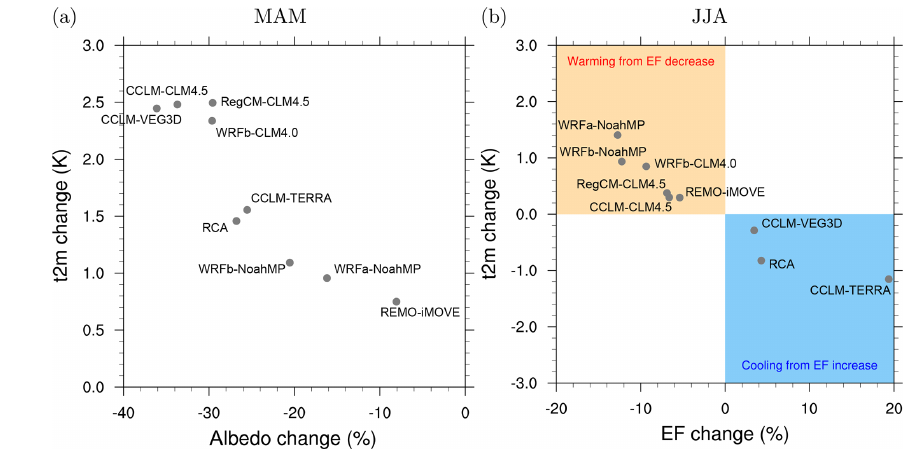
Figure 11. Illustrative relationships between changes (FOREST minus GRASS) in 2m temperature and albedo in spring (a) and between changes in 2m temperature and EF (evaporative fraction) in summer (b) for